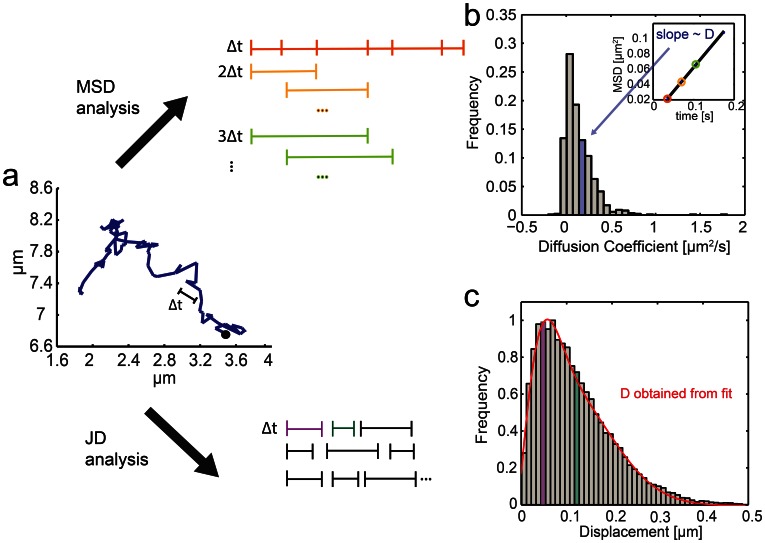
Principle of the mean-square displacement (MSD) and jump distance (JD) analyses.
(a) A typical single trajectory of receptor-bound LPS recorded in live macrophages (Δt = 33 ms). Trajectory data can be analyzed either by MSD or JD analysis. For MSD analysis, an average of the mean-square displacement is calculated over all points of the individual trajectory for multiples of the smallest resolved time intervals (Δt, 2Δt, 3Δt etc). The MSD plot over nΔt is linear and the gradient is directly proportional to the diffusion coefficient. (b) Diffusion coefficients are obtained for all single trajectories and typically presented in histograms. For a random walk with a single diffusion coefficient and long trajectories this distribution is centered around the diffusion coefficient. Multiple mobility populations can be resolved in principle, however a reliable dissection requires a fairly large data set (Note S3 in File S1). The JD analysis plots a histogram of all particle displacements within a fixed time interval Δt for all trajectories. (c) Fitting Eq. 7 to the distribution of the displacements yields the minimum number of diffusion coefficients needed to describe the motion of the particles in the system.